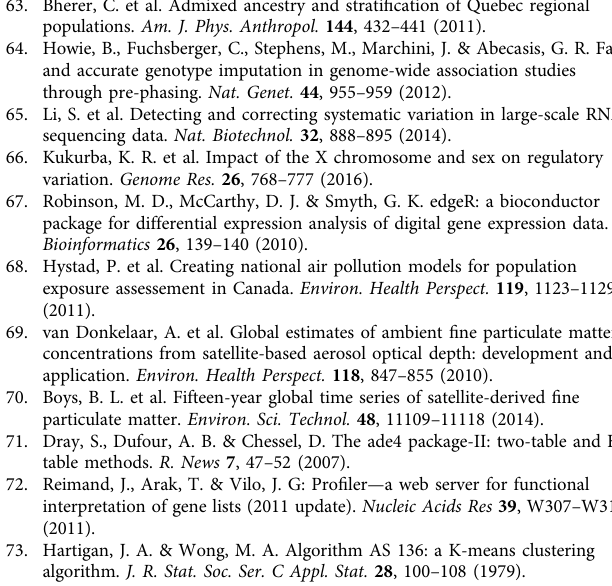
table methods. R. News 7 , 47 – 52 (2007). 72. Reimand, J., Arak, T. & Vilo, J. G: Pro fi ler — a web server for